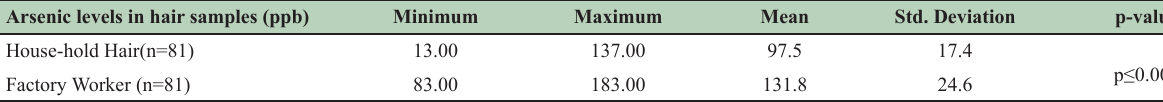
Table-II: Arsenic levels in a population under study.